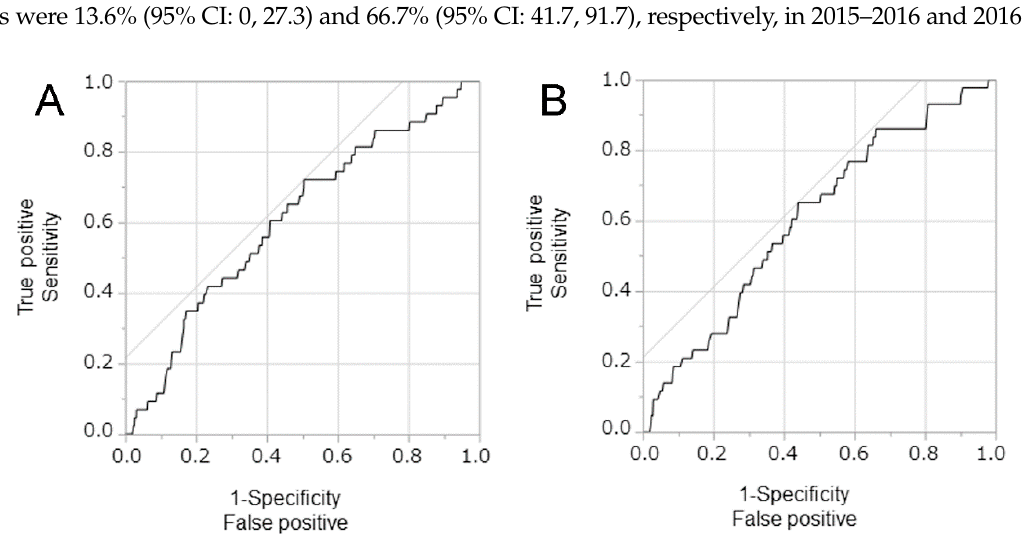
Figure 4. Predicted risk of observing a positive blood culture of Bacillus spp. Employing the temperature alone with a lag of six days, the risk of observing a case on each given day was estimated. Black bars represent true positive events of positive blood culture, whereas gray bars represent false negative events.